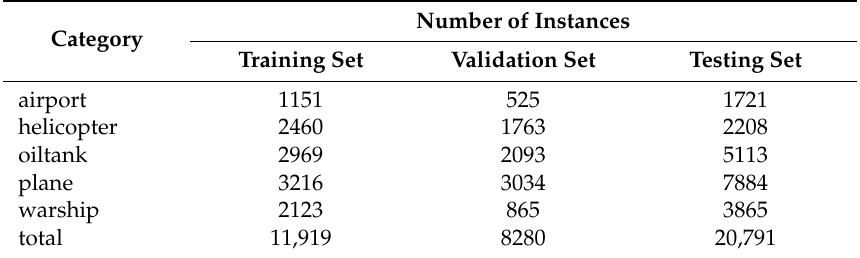
Table 1. The number of instances in three sets.